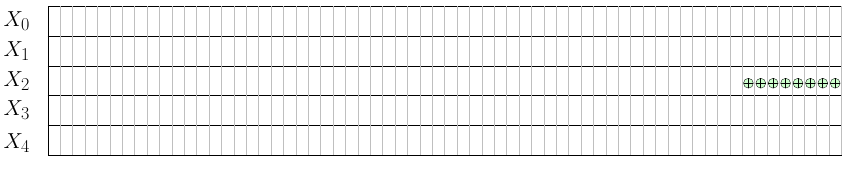
Figure 2: Addition of constants ( p C )